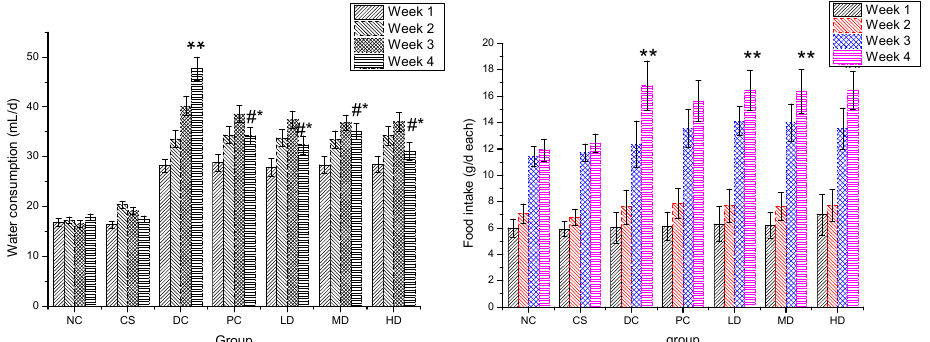
Figure 3. Water consumption ( a ) and food intake ( b ) of normal and STZ-induced diabetic mice. Results are presented as means ˘ SD ( n = 10). The columns of each index have * p < 0.05, ** p < 0.01 vs. NC; # p < 0.05 vs. week 1. Group abbreviations are as given in the caption of Figure